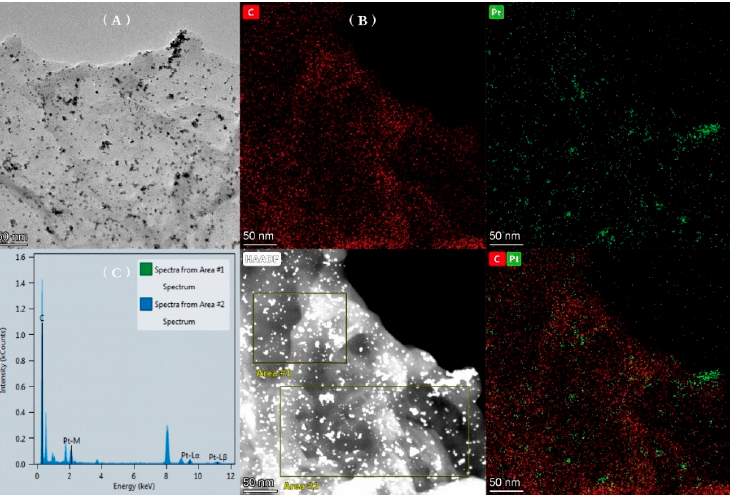
Figure 1. TEM image ( A ), elemental mapping ( B ) and EDS ( C )of PtNPs@GDY.